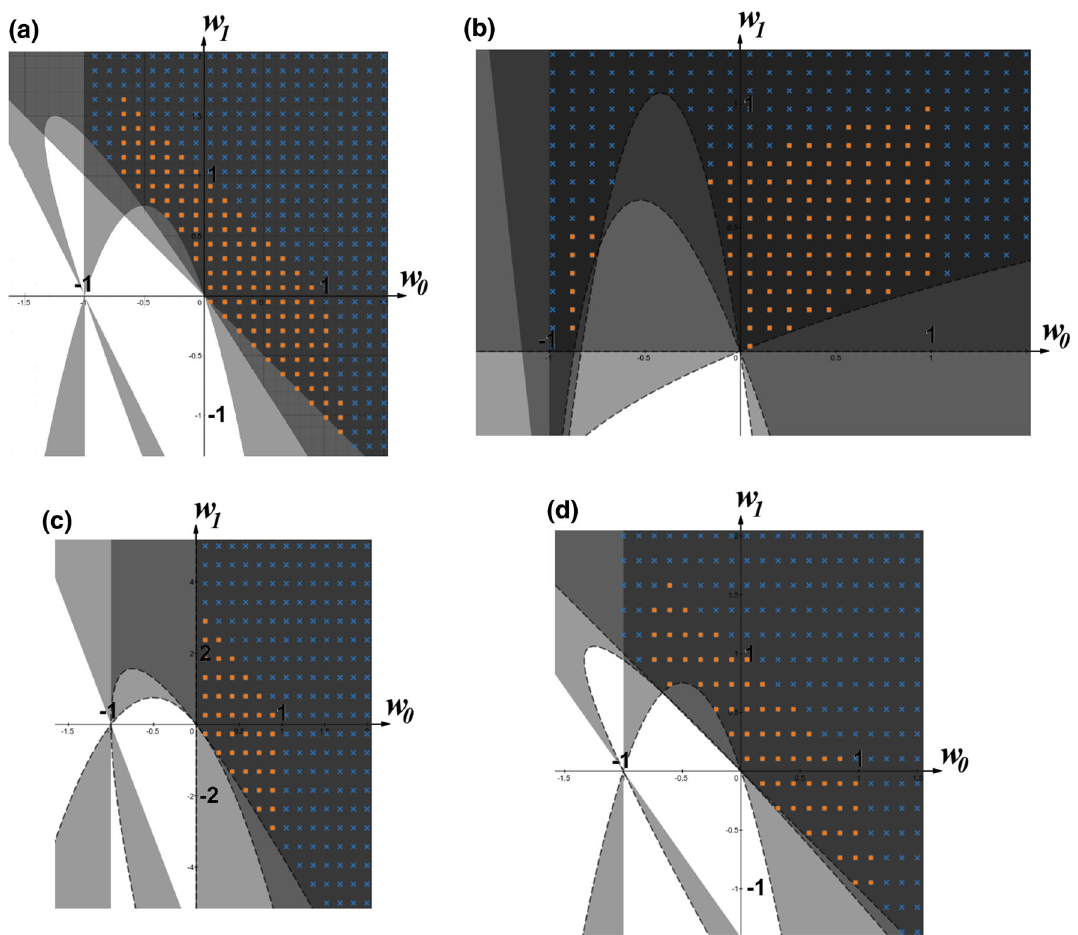
Fig. 4 Theallowedparemeterregionsforconditions0 ≤ c 2 s ≤ 1(dots) and 0 ≤ c 2 s (dots + crosses) for models: [20,21] in plot ( a ), [27] for a ∗ = a 0 / 3 in plot ( b ), [30] in plot ( c ) and [37] (model 1) for n = 3 in